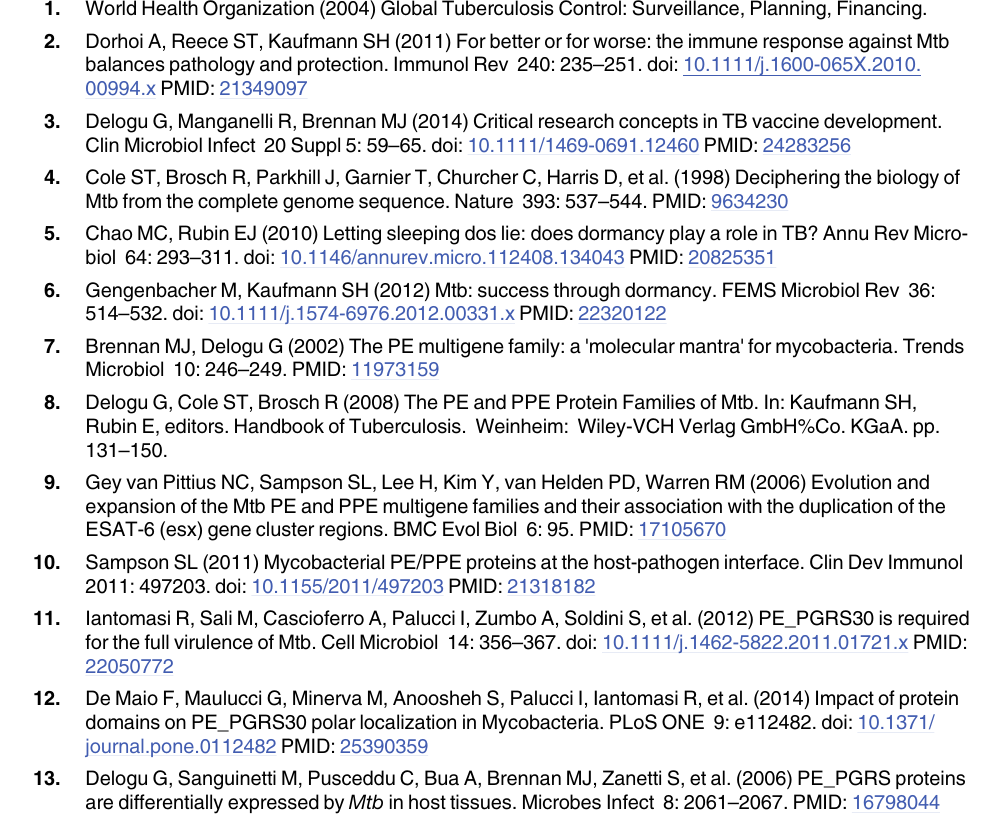
S1 Fig. Recombineering strategy to generate the knock out strain for the PE_PGRS33. (PDF) S2 Fig. schematic of the Rv1818c gene and PE_PGRS33 protein domains and demonstra- tion of PE_PGRS33 expression in the complemented strain Mtb Δ 33::PE_PGRS33 HA . (PDF) S1 Table. Primers and plasmids used in this